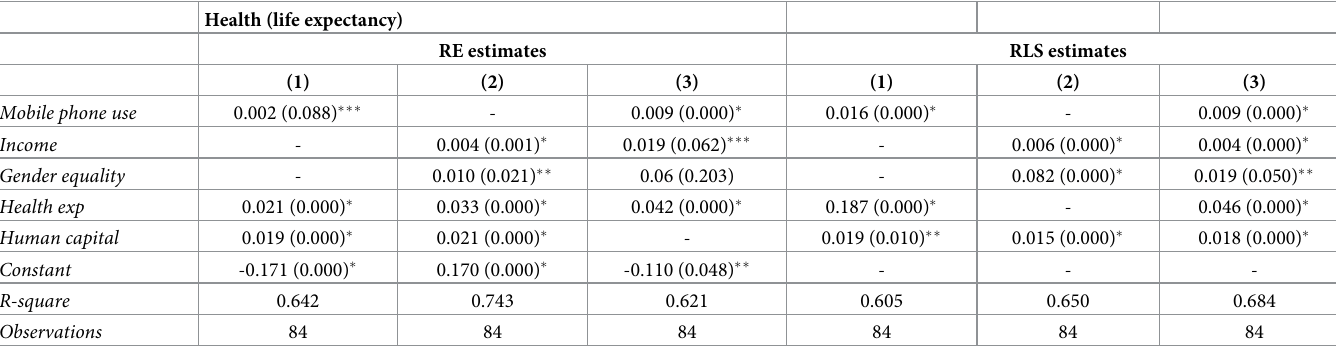
Table 8. Possible mechanism through which ICT can impact